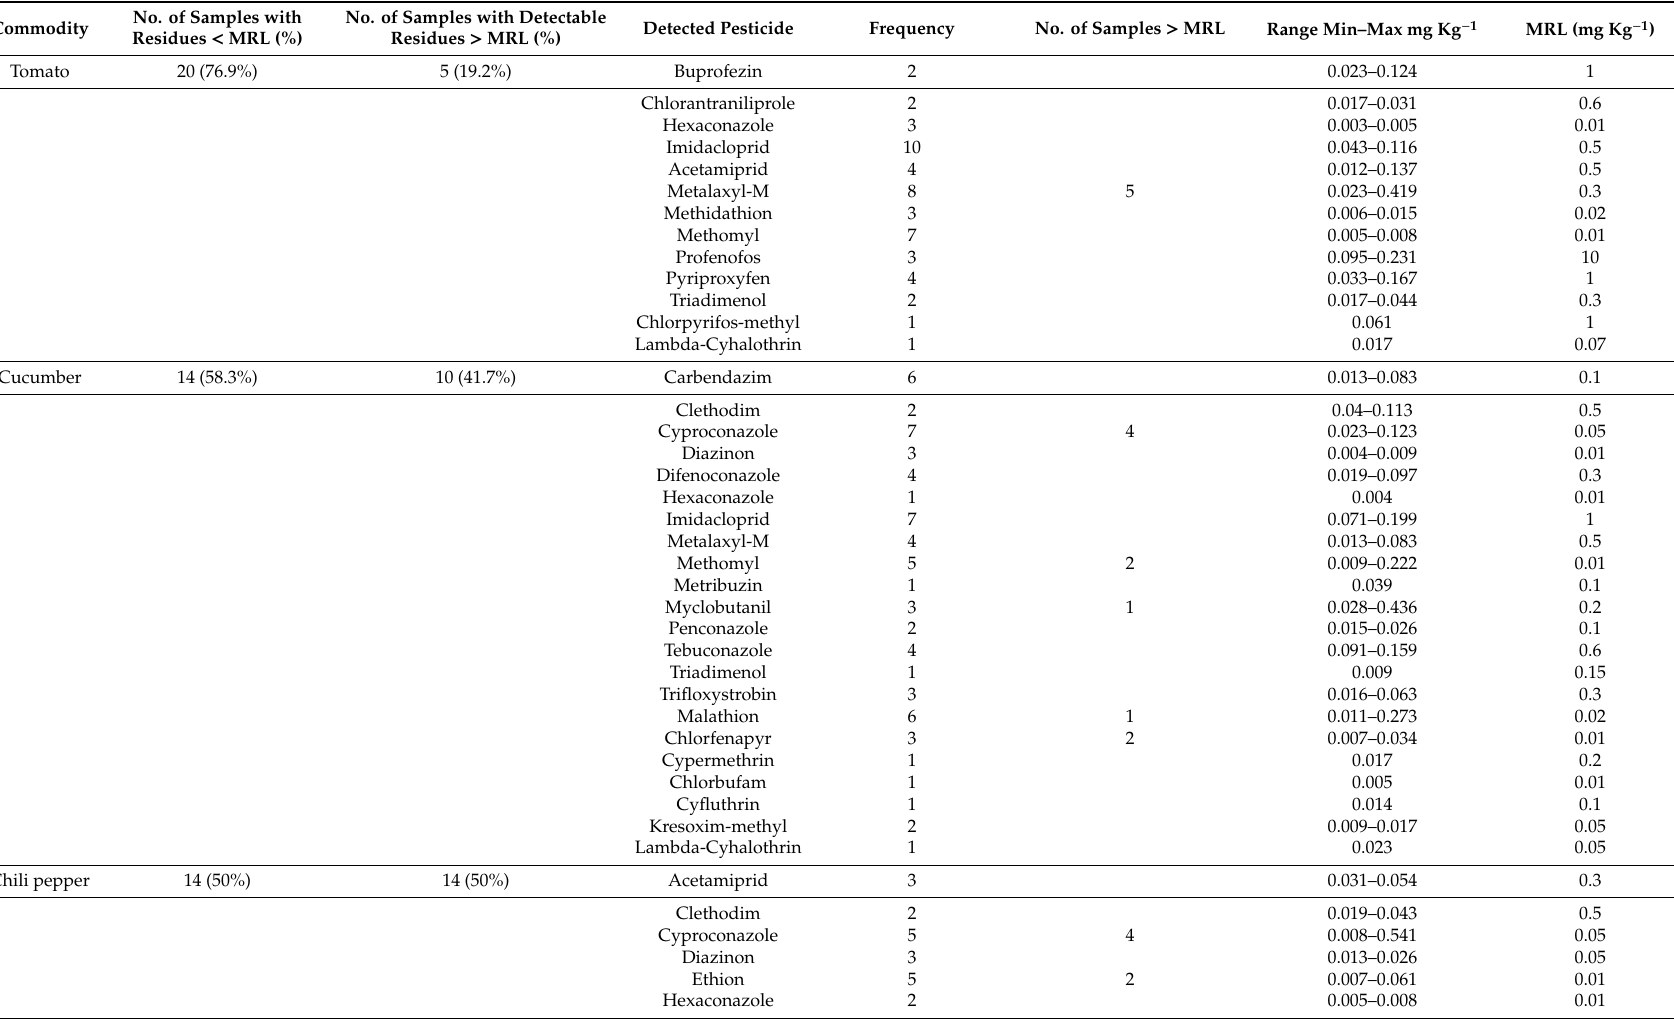
Table 3. Pesticide concentration ranges, frequencies, and MRLs in the analyzed vegetable